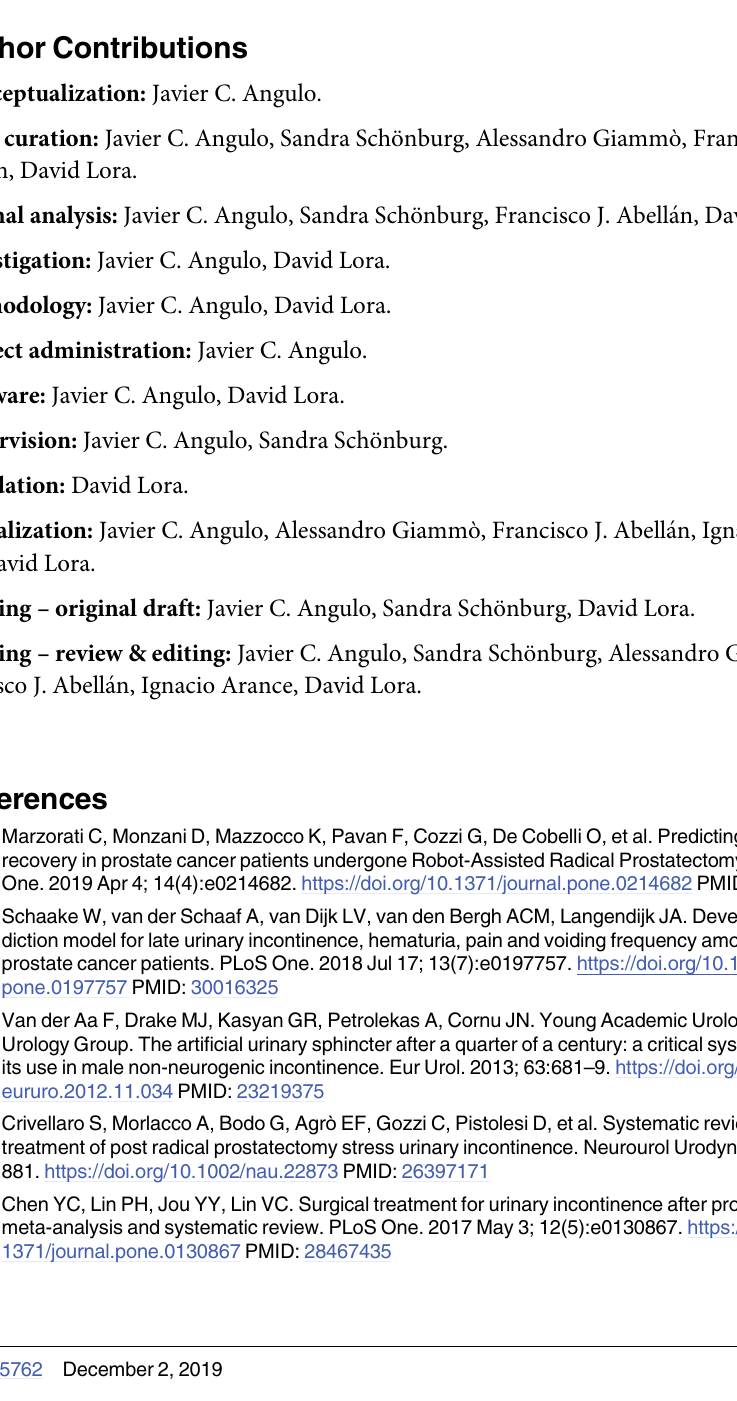
S3 Table. Random effect model (proportion estimate, 95% Confidence Interval) and quan- tifying heterogeneity (I2, p-value) for the study outcomes evaluated. (DOCX) S1 Fig. Freeman-Tukey double arcsine transform proportion for dryness (A), improvement (B), satisfaction (C), differential pad-count (D), differential pad-test (E), number of fillings (F), explant (G) and complication